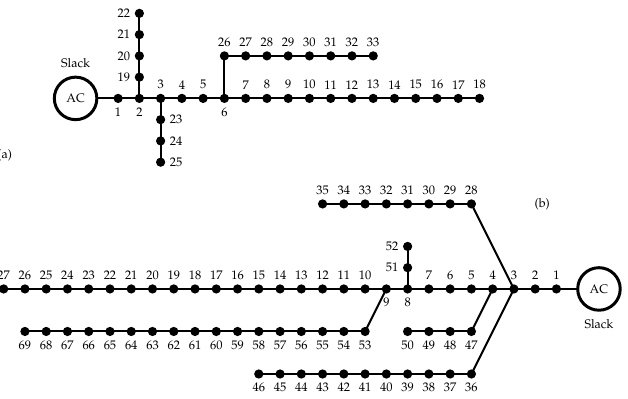
Figure 1. Nodal connections of the test feeder ( a ) IEEE 33-bus ( b ) IEEE 69-bus. The IEEE 33-bus has a total active and reactive power demand of 3715 kW and 2300 kvar with 210.9876 kW of power losses at the peak load condition; while the IEEE 69-bus has a total active and reactive power demand of 3890.7 kW and 2693.6 kvar with 224.9520 kW of power losses in the same operative scenario. All information regarding branches and loads are reported in Tables 2 and 3 [8]. Table 2. Electrical parameters of the 33-node test